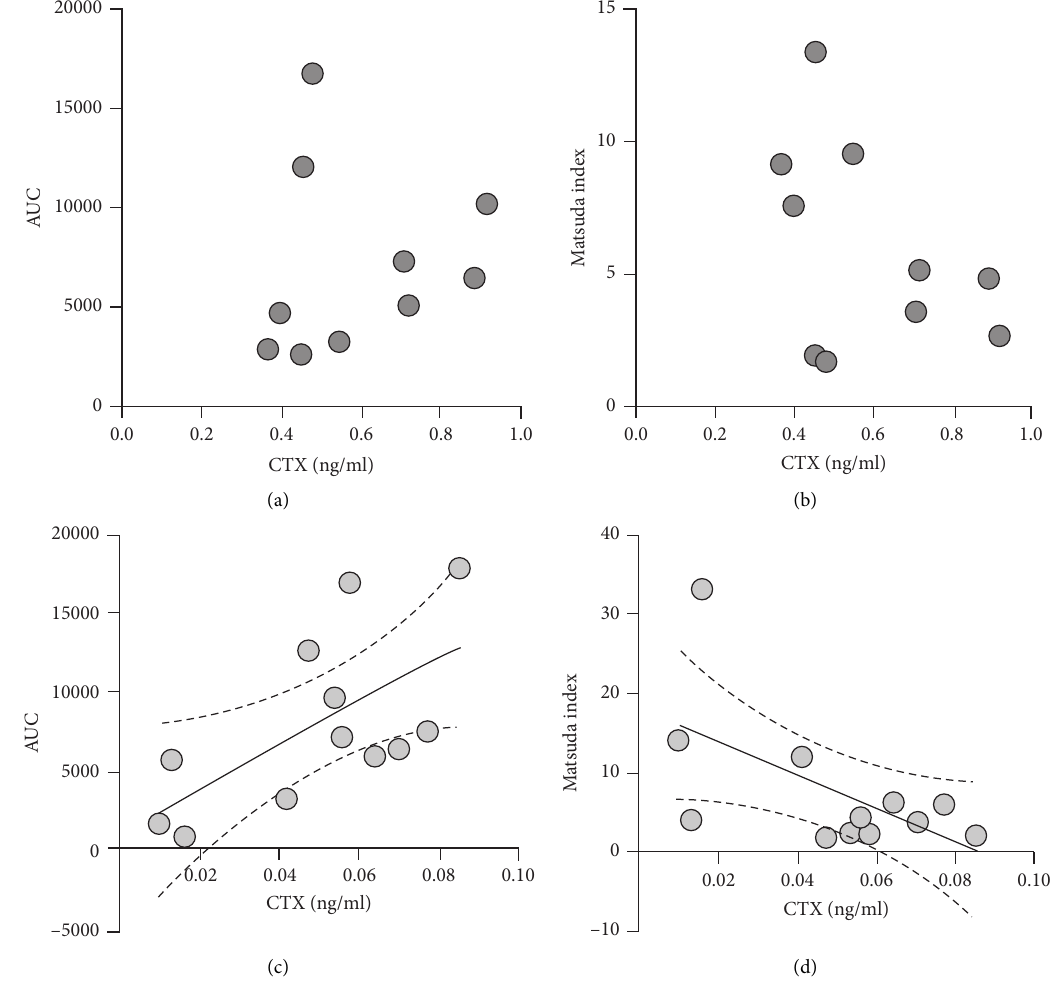
Figure 1: Correlations between serum CTX levels and OGTT-derived indexes of insulin sensitivity in postmenopausal breast cancer women treated with AIs at baseline and 1 month after 60mg Dmab administration. At baseline evaluation, no significant correlation could be detected between serum CTX levels and both insulin AUC (a) and Matsuda Index (b) while 1 month after Dmab injection, suppressed CTX levels positively correlated with insulin AUC (c) and negatively with Matsuda Index (d). Continuous line, linear regression; dashed lines, 95% confidence interval. AUC, area under the curve of serum insulin levels after 75g oral glucose load; CTX, C-terminal telopeptide of type 1